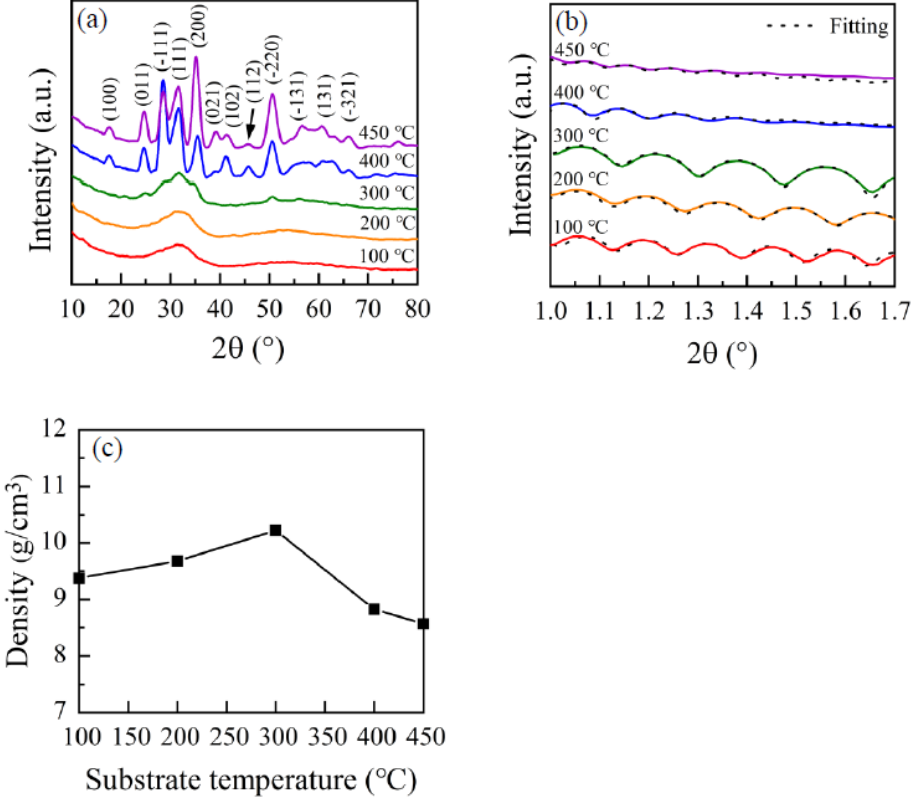
Figure 2. HfO 2 films deposited at 100 – 450 °C: ( a ) GIXRD patterns; ( b ) XRR patterns and measured fitting curves; ( c ) the extracted density.